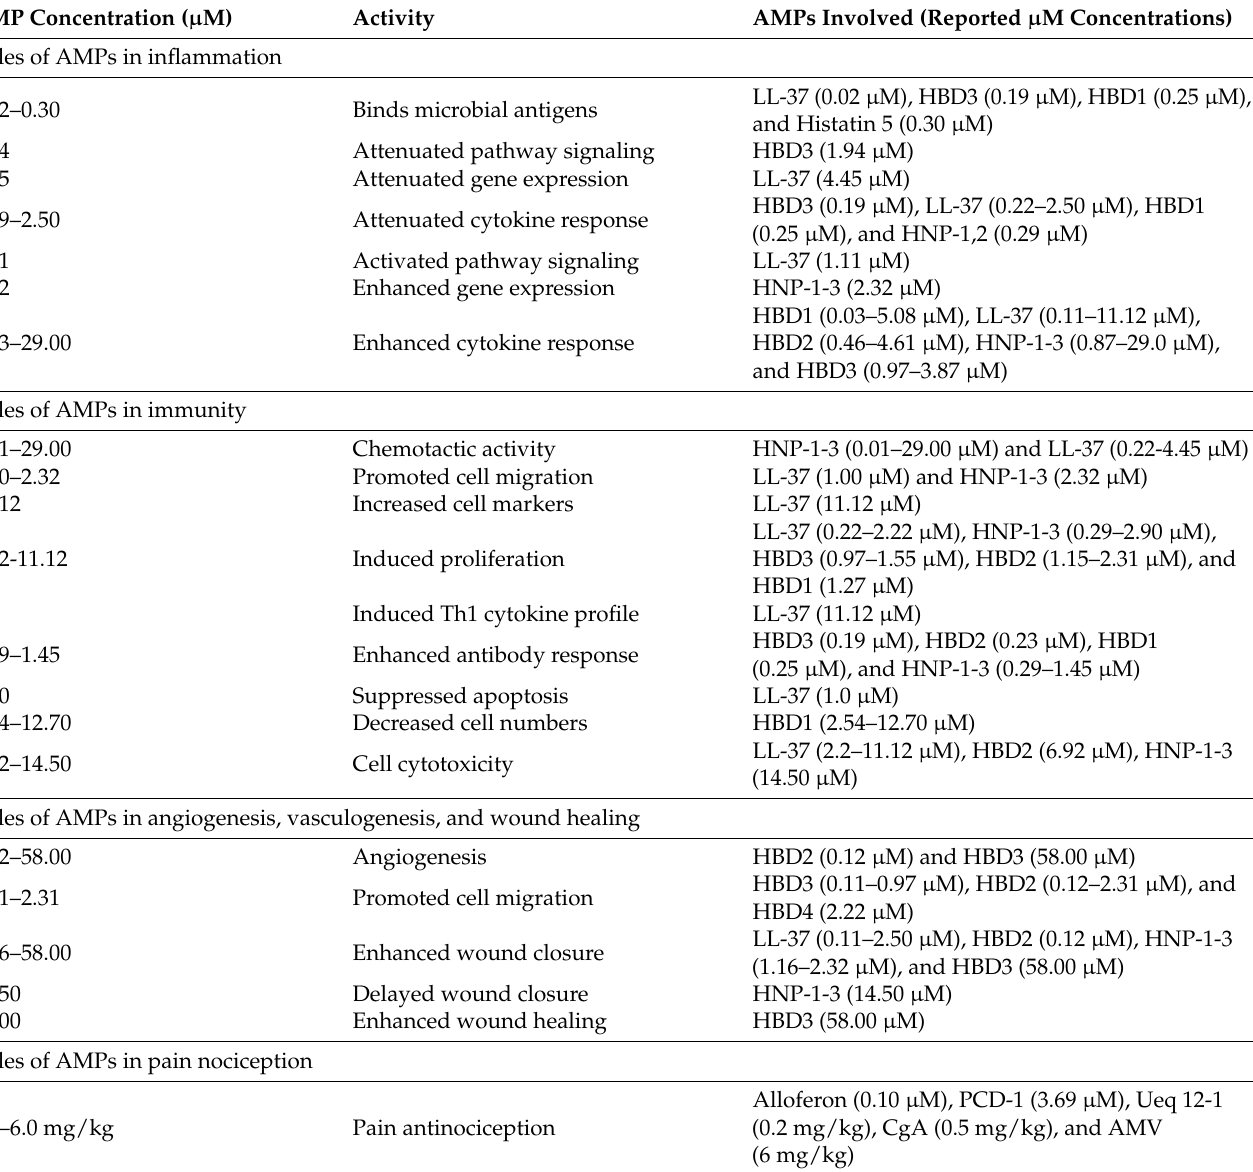
Table 2. Roles of AMPs in inflammation, immunity, healing, and pain. The activities below were compiled from results reported in Supplemental Table